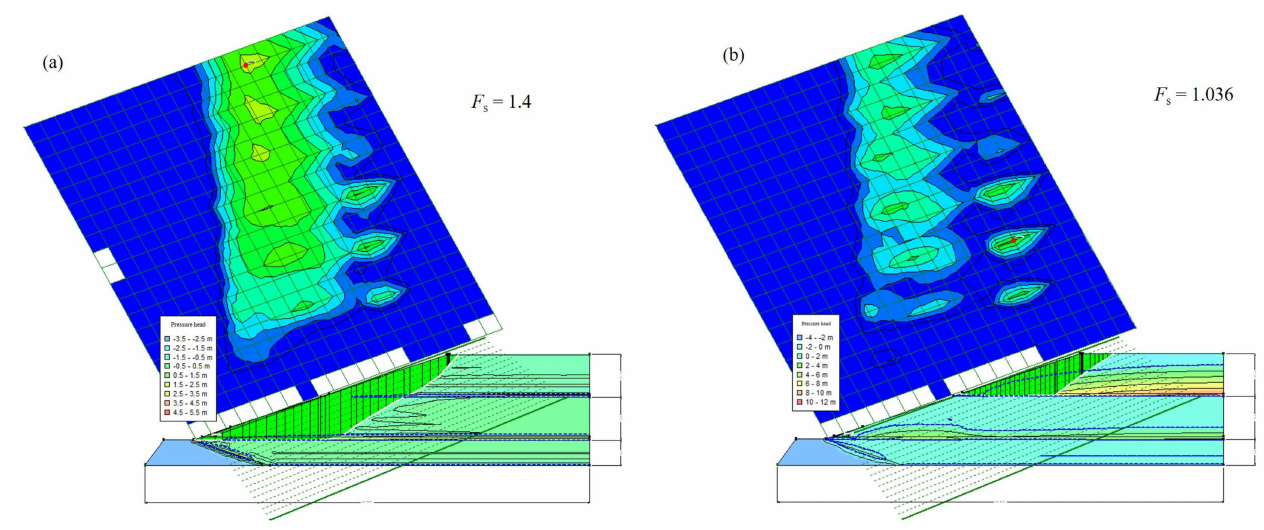
Figure 12. Slope failure surface and corresponding safety factor: ( a ) day 100; ( b ) day